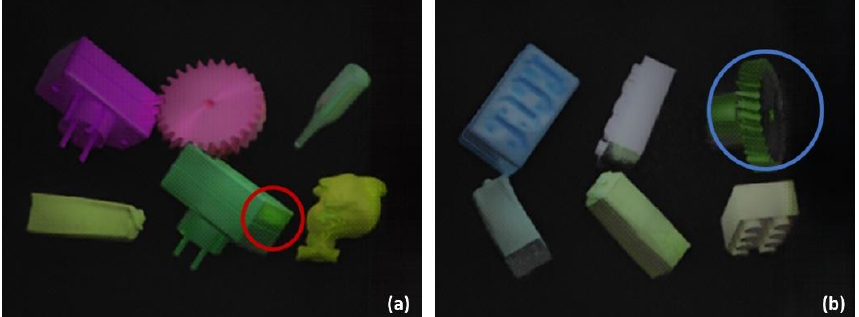
Figure 19. Limitations of the proposed SpecToPoseNet . ( a ) Inter-reflection; ( b )